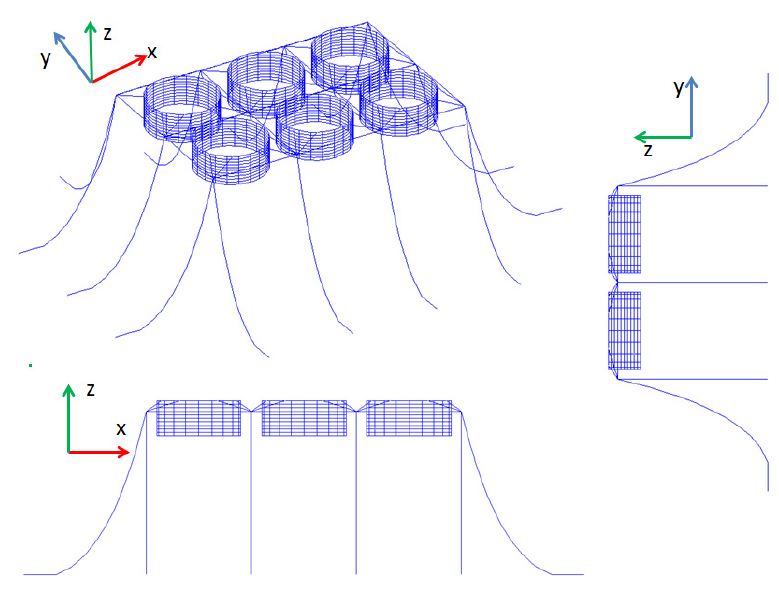
Figure 2. The schematic diagram of the entire numerical model. Table 2. The main dimensions and material parameters of the numerical model.